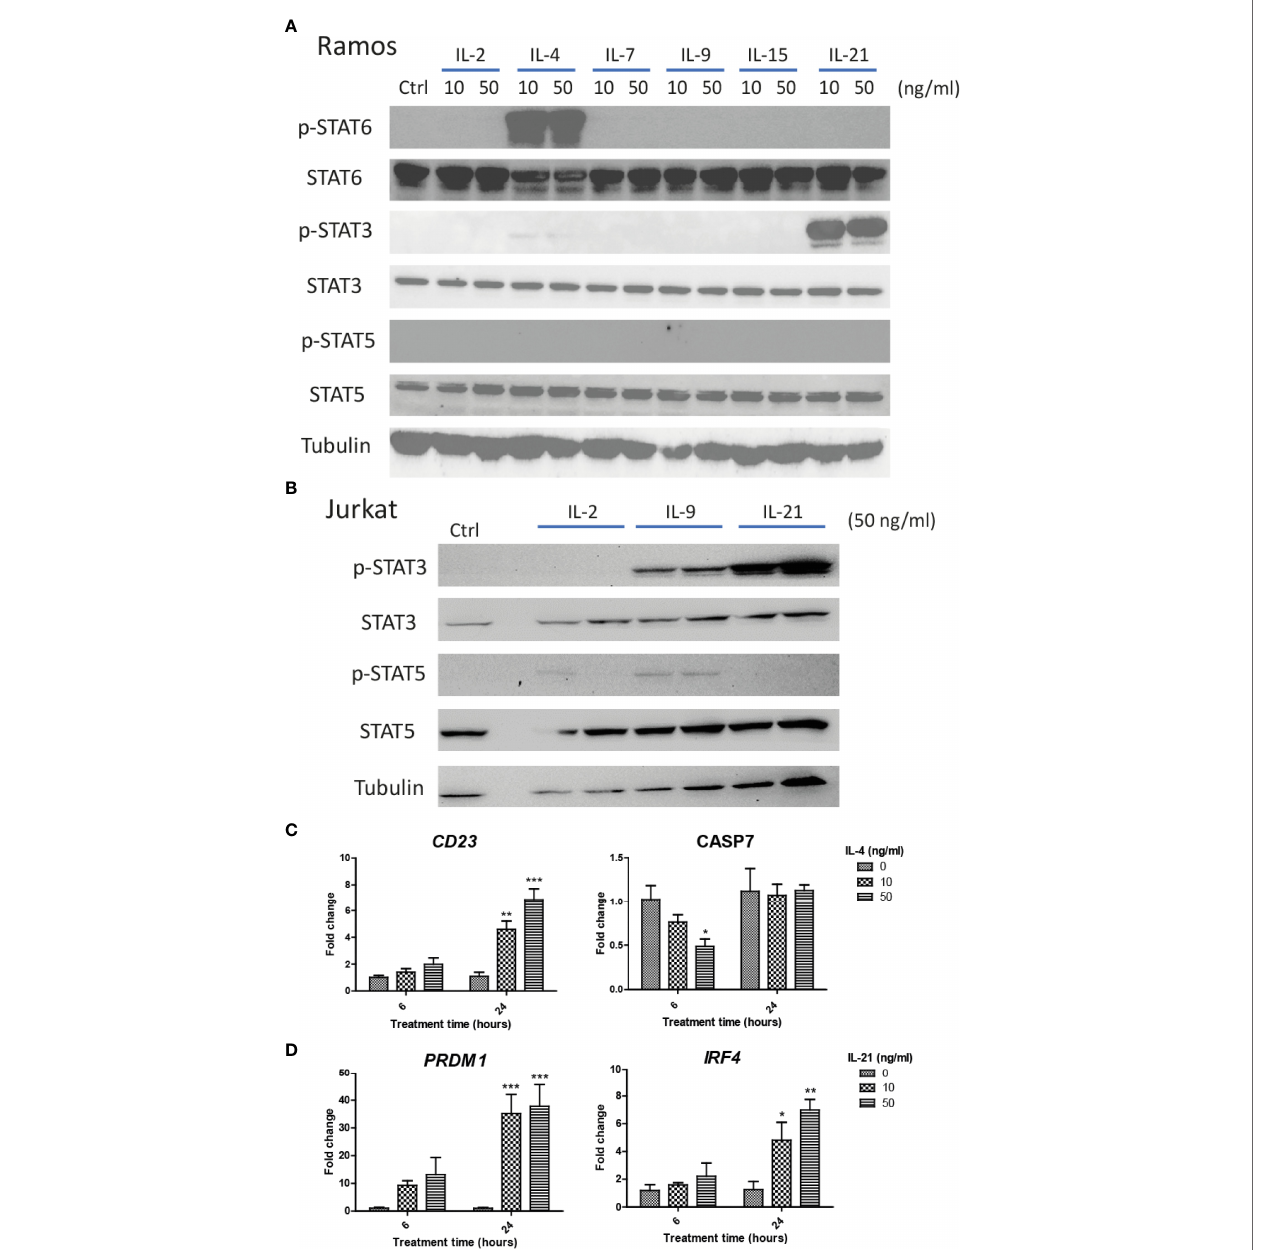
FIGURE 1 | IL-4 and IL-21 activated JAK/STAT pathways and stimulated downstream gene expressions in Ramos B cells. Ramos and Jurkat were treated with g c cytokines for 15 mins and harvested for western blot analyses. (A) IL-21 and IL-4 signi fi cantly induced STAT3 and STAT6 phosphorylation respectively. No STAT5 phosphorylation was observed in Ramos cells after any cytokine treatments. (B) IL-2, IL-9 and IL-21 treatments triggered STAT3 and STAT5 phosphorylation in Jurkat cells. Ramos cells were starved in serum-free RPMI1640 medium for 24 hours and treated with either IL-4 or IL-21 for 6 and 24 hours. (C) IL-4 signi fi cantly reduced CASP7 and induced CD23 expressions dose dependently at 6 and 24 hours respectively. (D) IL-21 signi fi cantly induced PRDM1 and IRF4 expressions dose dependently at 24 hours. *p < 0.05, **p < 0.01, ***p < 0.001 as compared to vehicle controls art respective time points by one-way ANOVA, N =